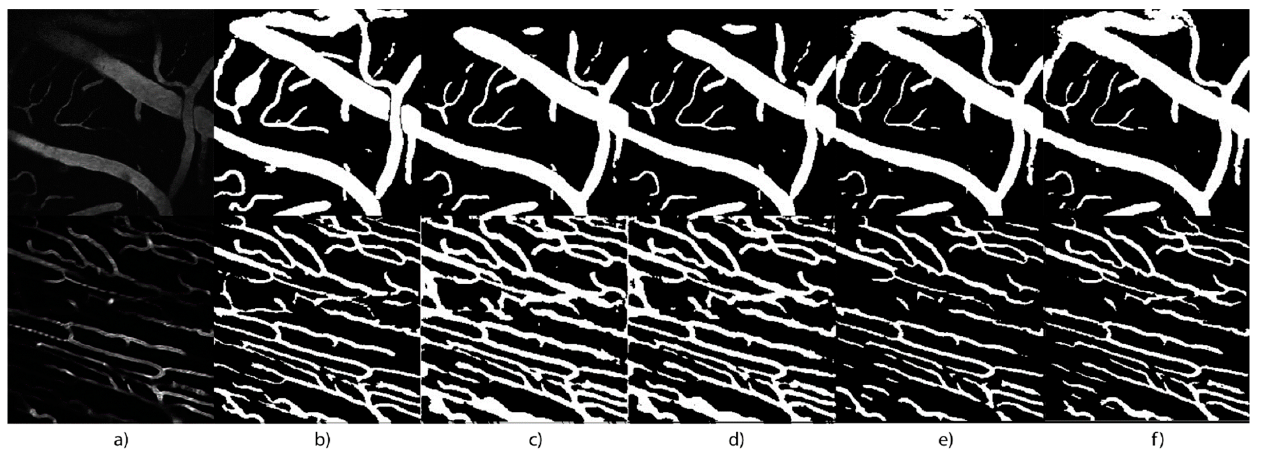
Figure 10. Sample of the segmentation maps for blood vessels obtained from the trained models on